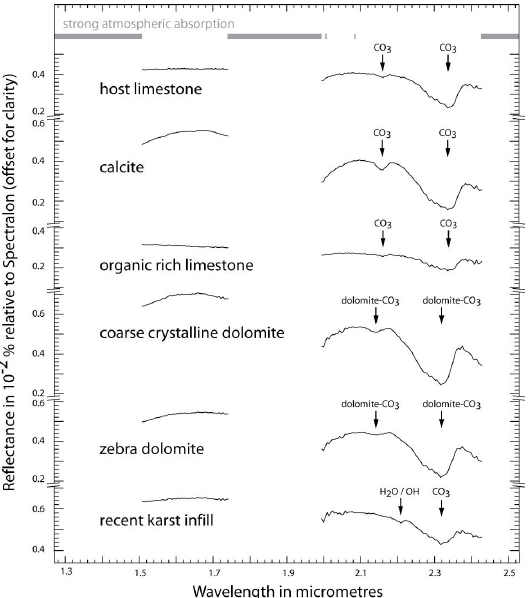
Figure 2. End-member spectra from the Pozalagua quarry, data collected with the HySpex SWIR-320m sensor (after Kurz et al.,